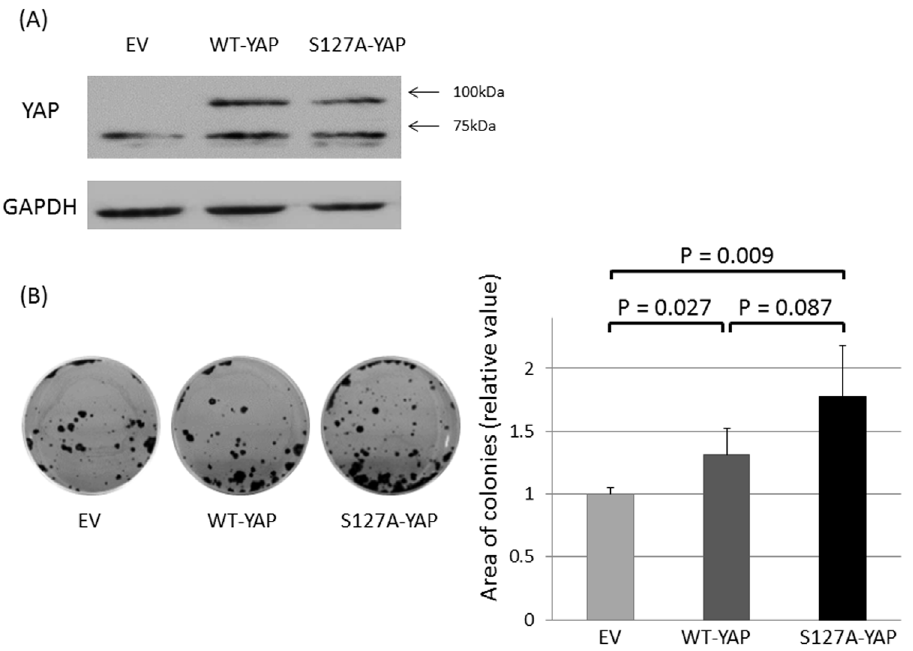
Figure 4. (A) Endogenous expression of YAP (approximately 65 kDa) and exogenous expression of YAP tagged with GFP protein (approximately 92 kDa in total) in HEC-1-A cells transfected with wild-type YAP (WT-YAP) and S127A mutant YAP (S127A-YAP). (B) Representative image of colony formation assay (left). Cells were transiently transfected with empty vector (EV)/WT-YAP/S127A-YAP and selected with appropriate concentrations of G418 for four weeks. The drug-resistant colonies formed by the YAP-transfected cells were significantly numerous compared with the control (the Mann-Whitney U-test). Columns and bars represent means and standard deviation in quadruplicate experiments. Similar trends were obtained in another independent experiment.